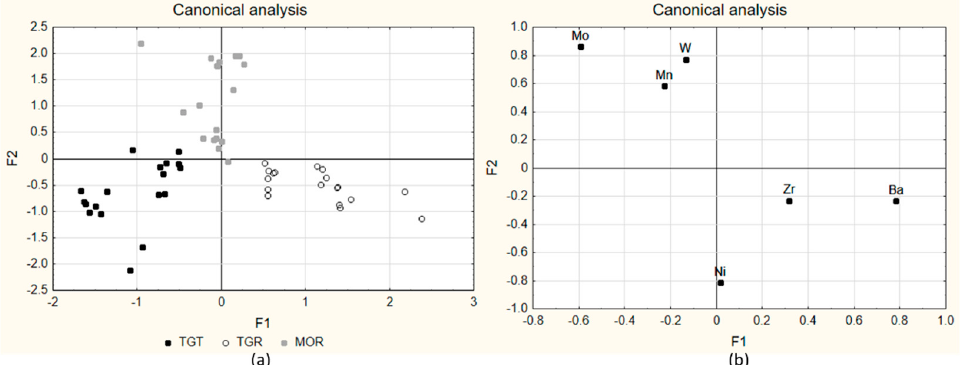
Figure 3. LDA score plot of the 54 samples, F1 vs. F2 for the classification according to the cultivar: score plot of the canonical variables ( a ); loading plot of the canonical variables ( b ).